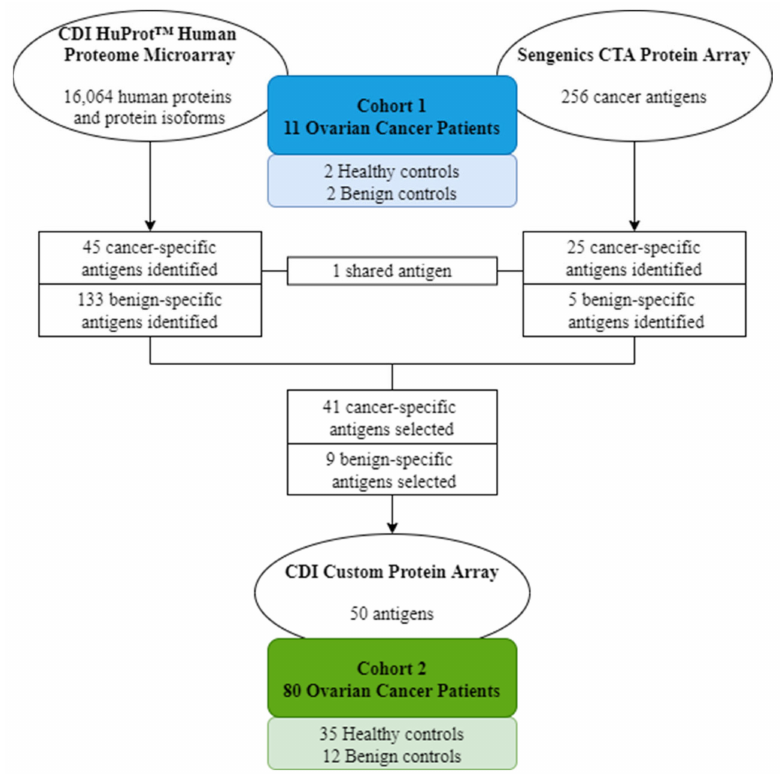
Figure 4. Study design diagram. Ovarian cancer cohort 1 and selected healthy and benign controls were screened using the CDI HuProt TM array and the Sengenics CTA protein array, which led to the identification of 50 candidate antigens. A custom array was developed and used to screen ovarian cancer cohort 2, as well as healthy and benign